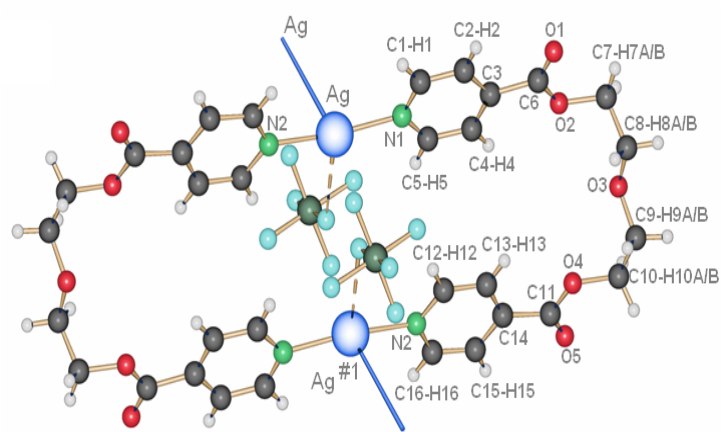
Figure 15. Metalla-cycle obtained for compound 15